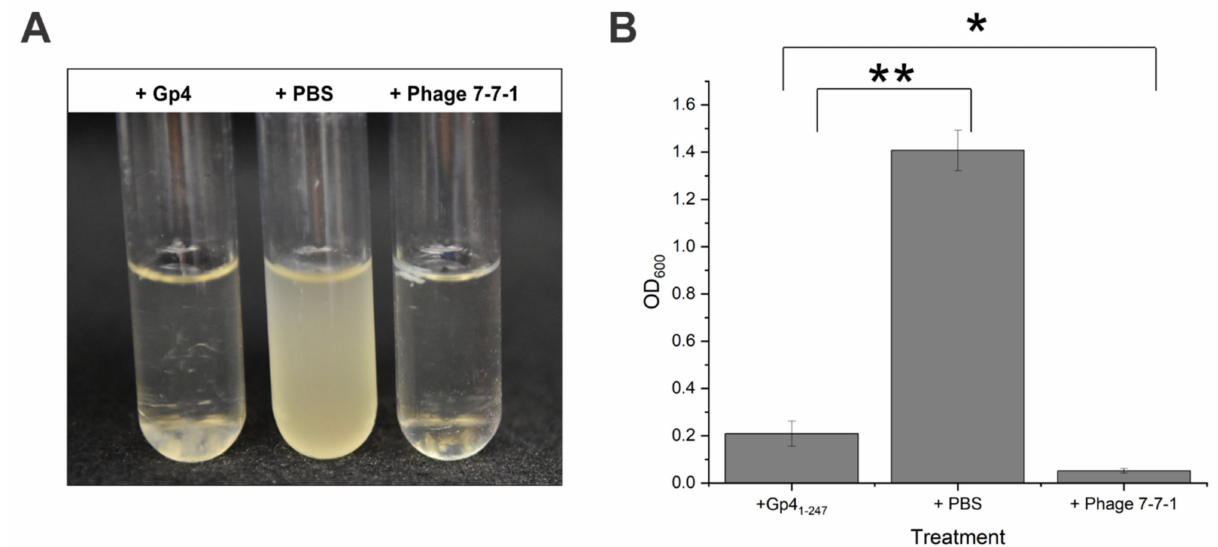
Figure 5. Effect of purified Gp4 on liquid cultures. Liquid cultures of Agrobacterium sp. H13-3 (OD 600 = 0.03) received purified 40 µ L Gp4 (0.06 µ g/ µ L), PBS, or phage 7-7-1 (MOI = 1) and incubated at 30 ◦ C for 24 h. Representative images of the cultures are shown in ( A ) while the final densities are illustrated in ( B ). Data reflects 3 biological replicates conducted in triplicate. The error bars represent standard deviations for each data set (student’s t test for Gp4 1-247 and phage 7-7-1 treatments, p < 0.05; student’s t test for Gp4 1-247 and PBS treatments, p < 0.01). The “*” denotes a p-value below 0.05 while the “**” indicates a p -value below